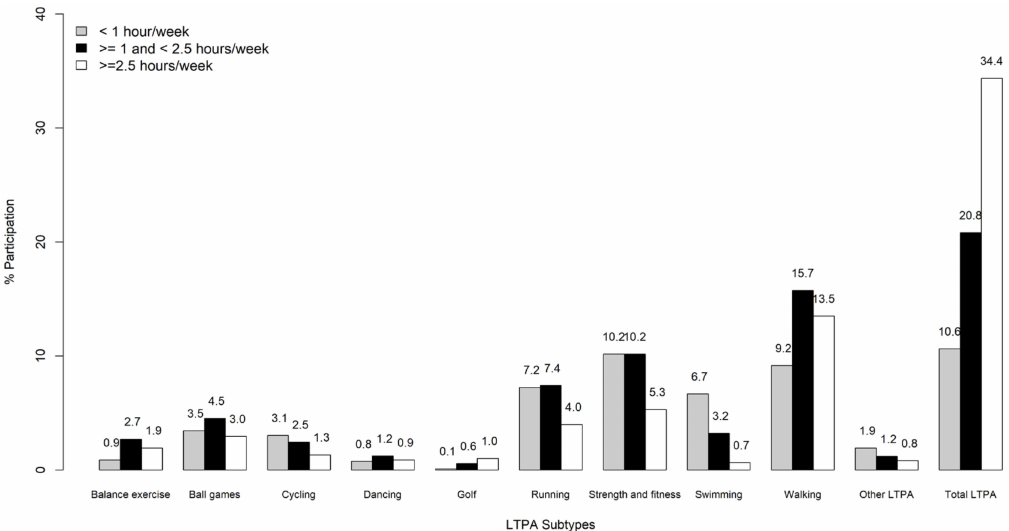
Figure 1. Proportion of duration of participation among various leisure time physical activities.